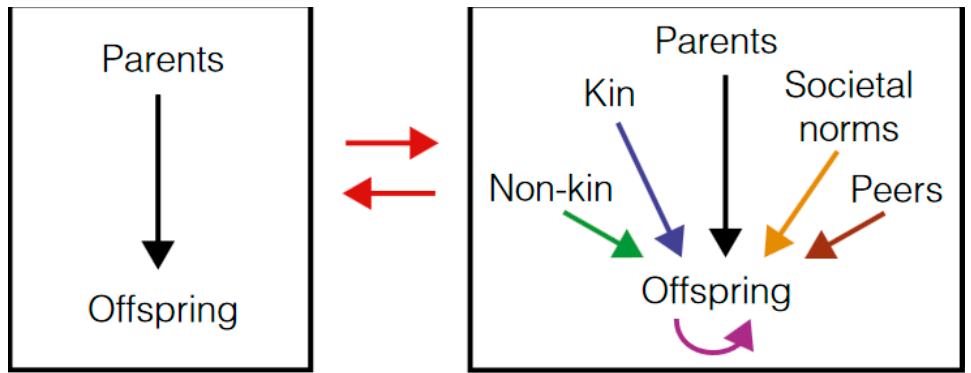
Figure 1. The factors involved in the transmission of cultural evolution (learning) are more complex than those of biological evolution (genetic inheritance) and can occur in short time intervals even in a single generation (modified from Creanza, Kolodny and Feldman).